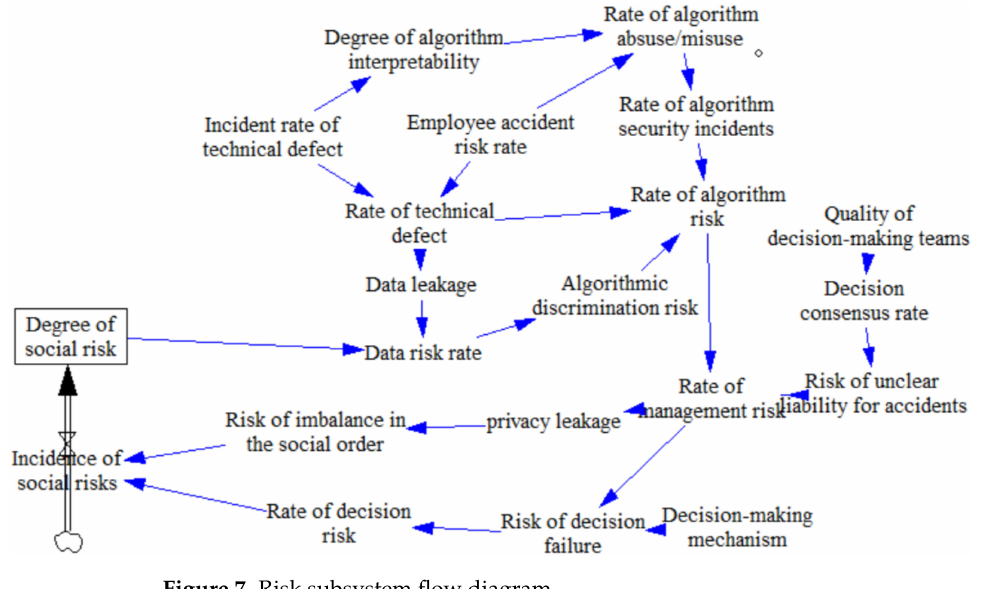
Figure 7. Risk subsystem flow diagram.